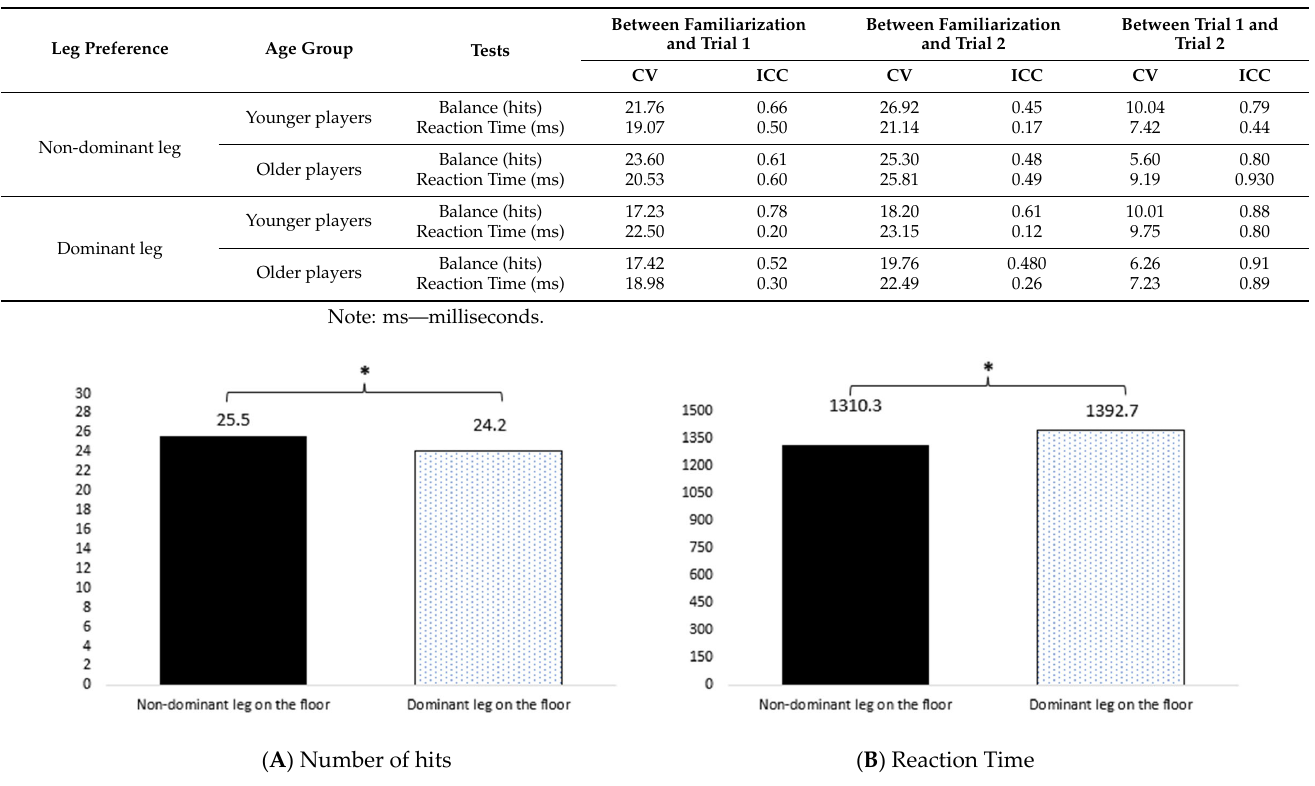
Table 4. Coefficient of variation (CV) and intra-class coefficient correlation (ICC) between trials.